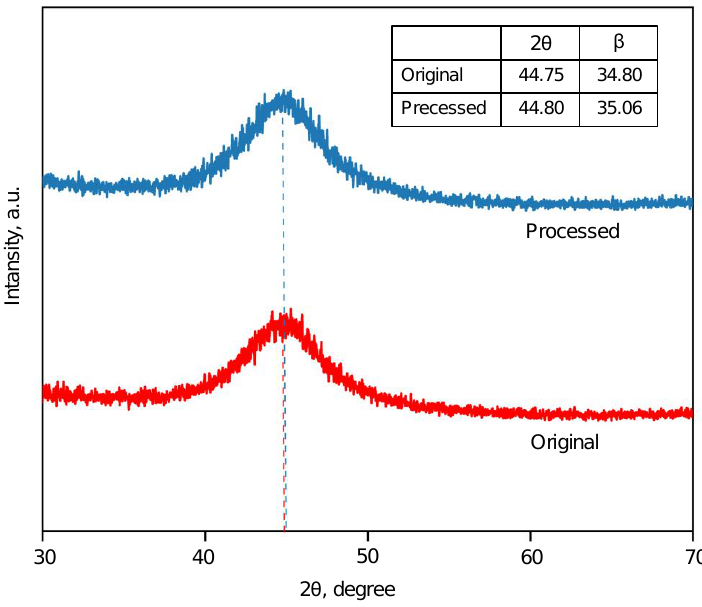
Figure 7. XRD patterns of the original and processed AA ribbons.